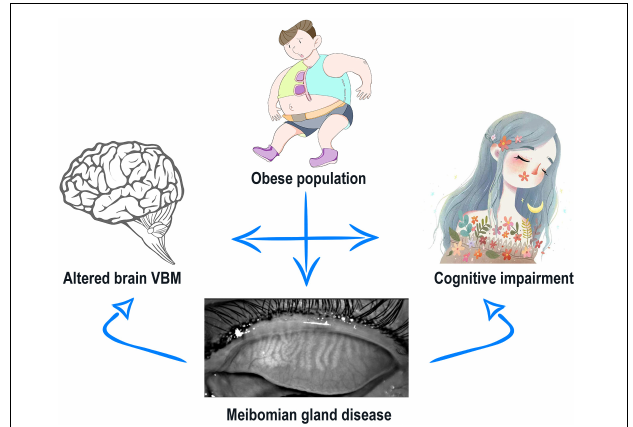
FIGURE 4 | Relationship between altered VBM values and cognitive impairment in severely obese patients with meibomian gland disease. Severely obese have increased likelihood of meibomian gland disease (MGD). MGD then leads to altered VBM values in specific brain areas of PATs compared with HCs. PATs are more likely to have cognitive impairments, which may correlate with the abnormal brain VBM. Abbreviations: VBM, voxel-based morphometry; PATs, severely obese patients with meibomian gland disease; and HCs, healthy controls.